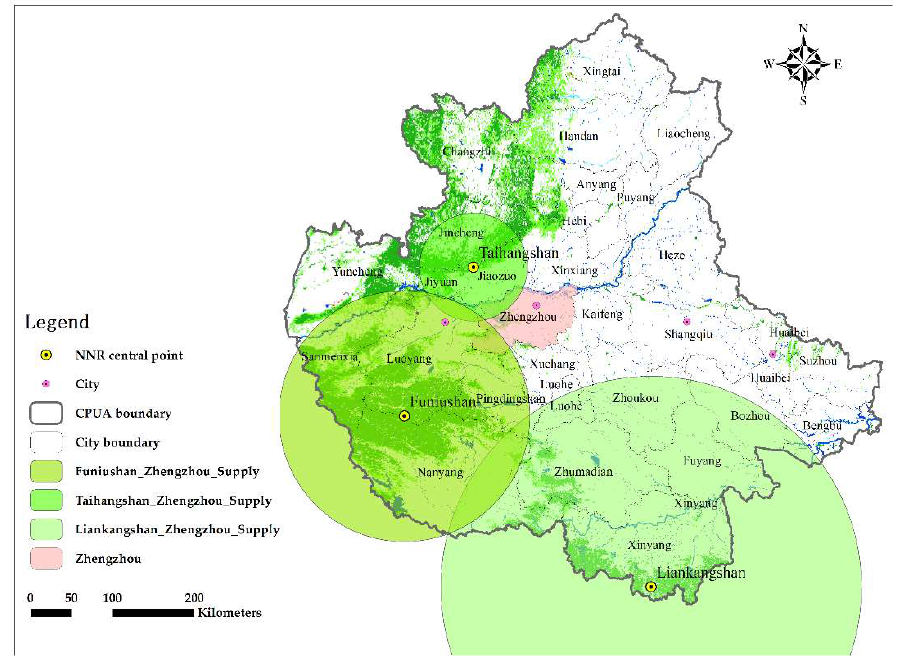
Figure 8. Integrated ES supplies of ecospace ES to Zhengzhou.